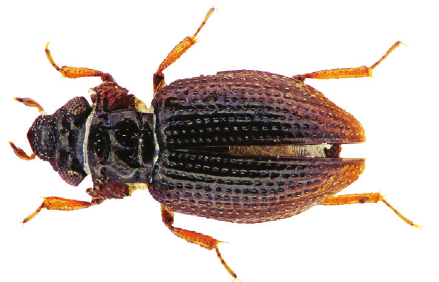
Figure 39. Aulachochthebius cf. continentalis